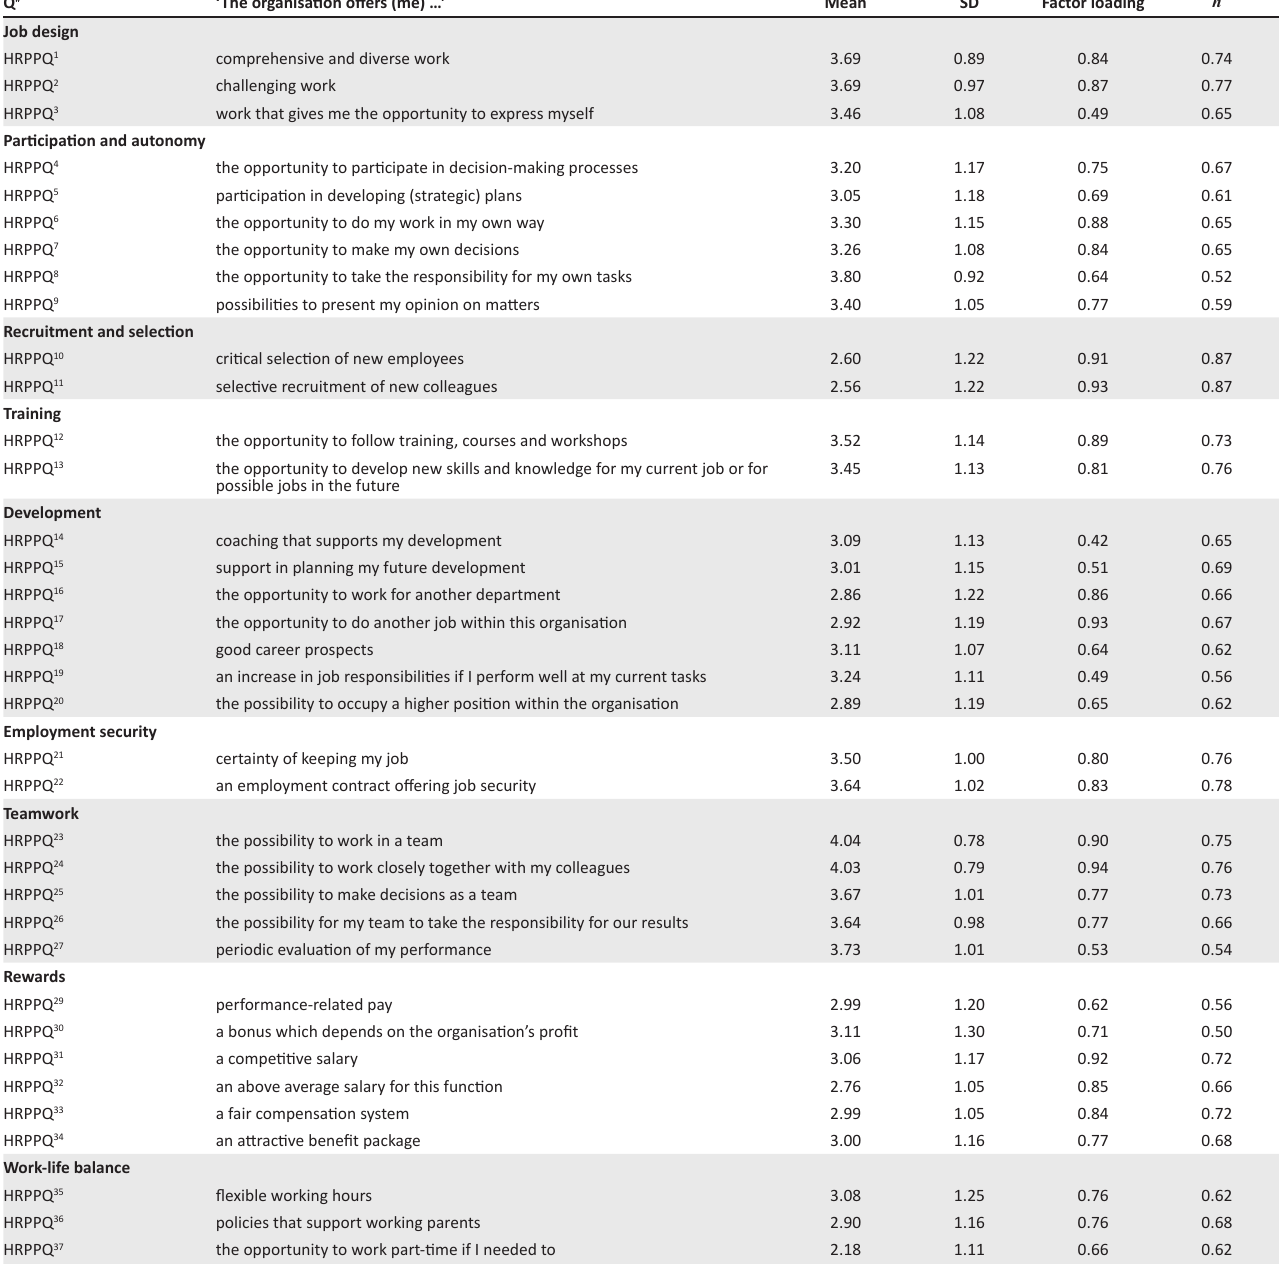
TABLE 3: Factor loadings (Promax rotation) and descriptive statistics of items on the Human Resource Practices Perceptions Questionnaire. Q # ‘The organisation offers (me)